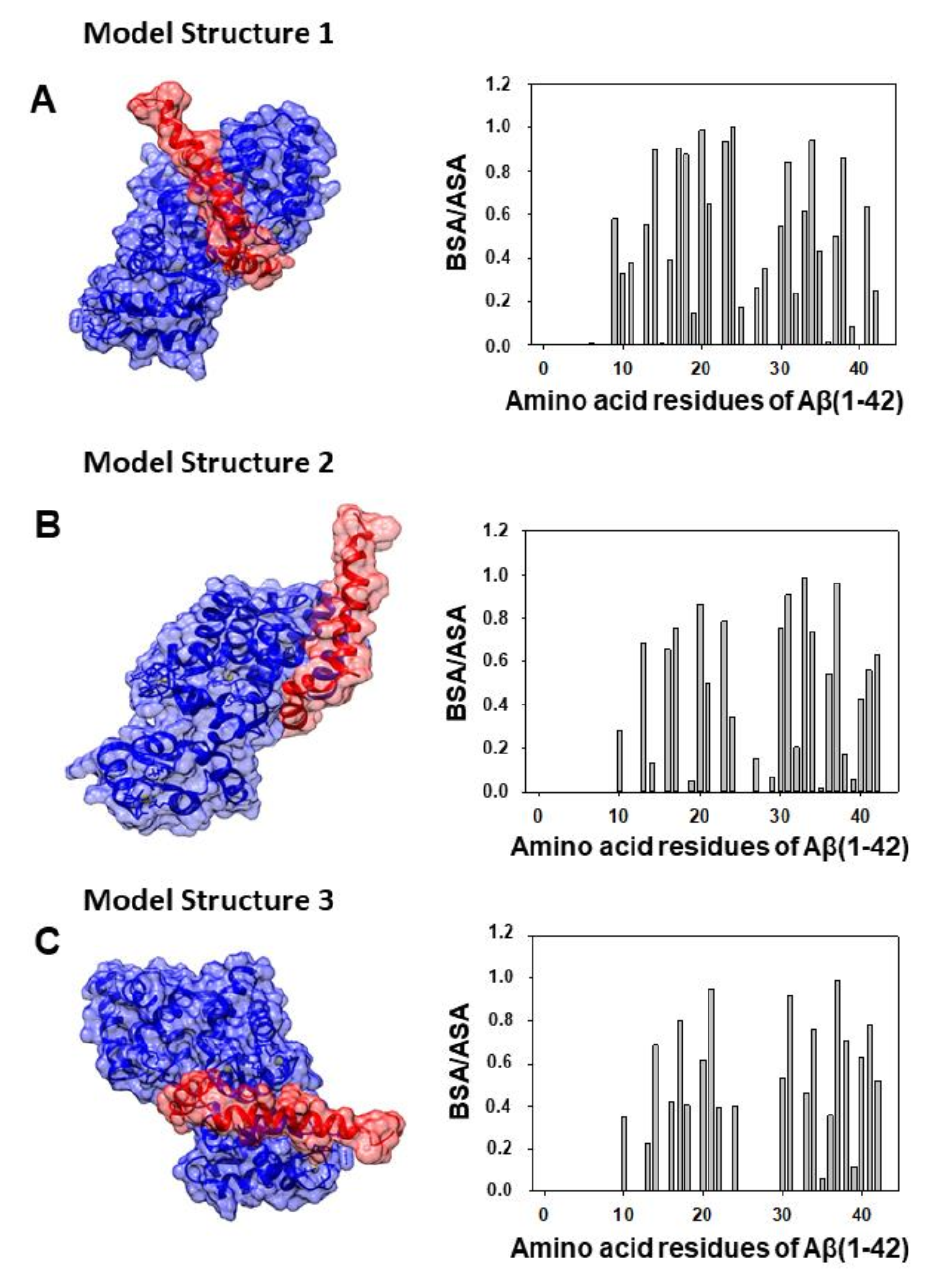
Figure 7. Selected in silico model structures of the complex A β (1–42):calbindin-D28k obtained using the PDB ID files: 1IYT for A β (1–42) and 6FIE for calbindin-D28k. ( A ) Model structure 1. ( B ) Model Structure 2. ( C ) Model structure 3. For each model structure of the A β (1–42):calbindin-D28k complex a space-filled image with highlighted peptide and protein backbones is shown. A β (1–42) is stained in red and calbindin-D28k is stained in blue in the space-filled image. The graphic charts of the BSA/ASA values obtained for the amino acids residues of A β (1–42) in the in silico model structures 1, 2 and 3 of the A β (1–42):calbindin-D28k complex are also shown in each panel ( A – C ) of this figure next (at the right-side) of each space-filled image. Docking was performed as indicated in the Materials and